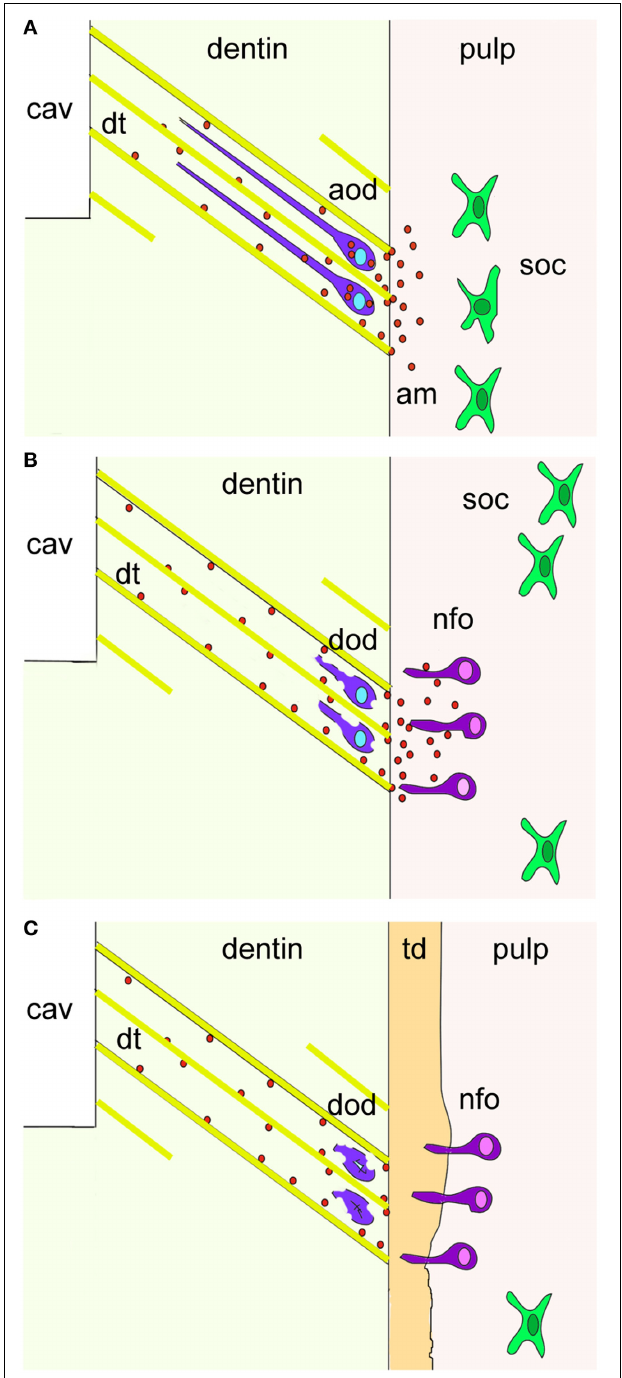
FIGURE 4 | A hypothetical model summarizing the cellular events after dental injury. Cavity preparation (cav) leads to the apoptosis of odontoblasts due to their aspiration into the dentinal tubuli (dt; yellow color). Amelogenin molecules (am; red spots) secreted by aspirated odontoblasts (violet color) before undergo apoptosis activate pulp progenitor cells such as sub-odontoblastic cells (soc; green color) to differentiate into new-odontoblasts (nfo; dark pink color) that start to form the tertiary dentin (td; orange color). Additional abbreviations: aod, apoptotic odontoblasts; dod, disintegrated